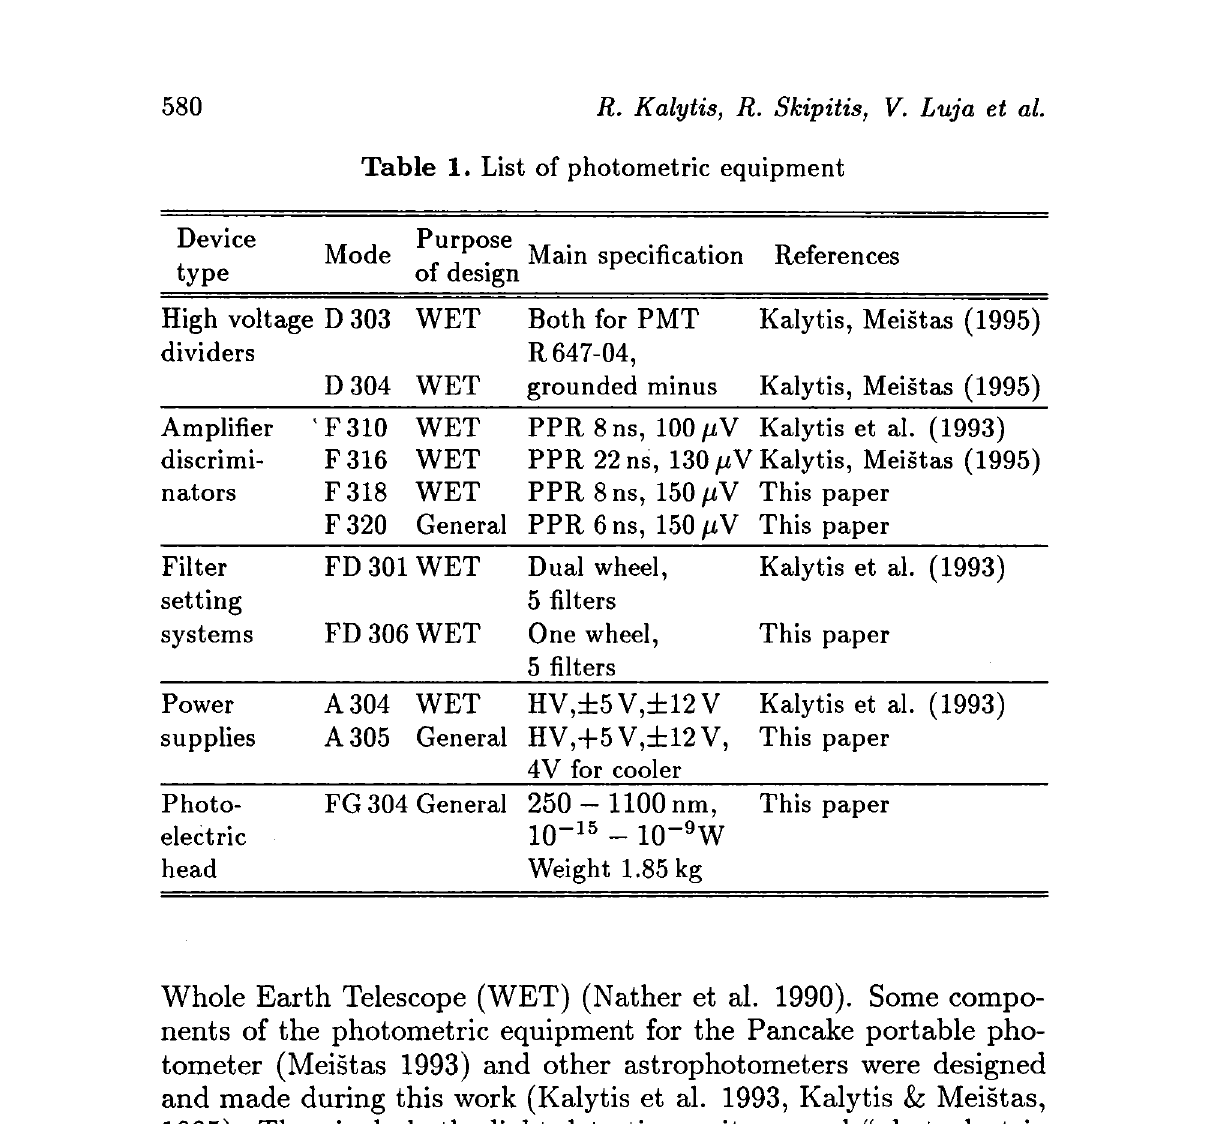
Table 1. List of photometric